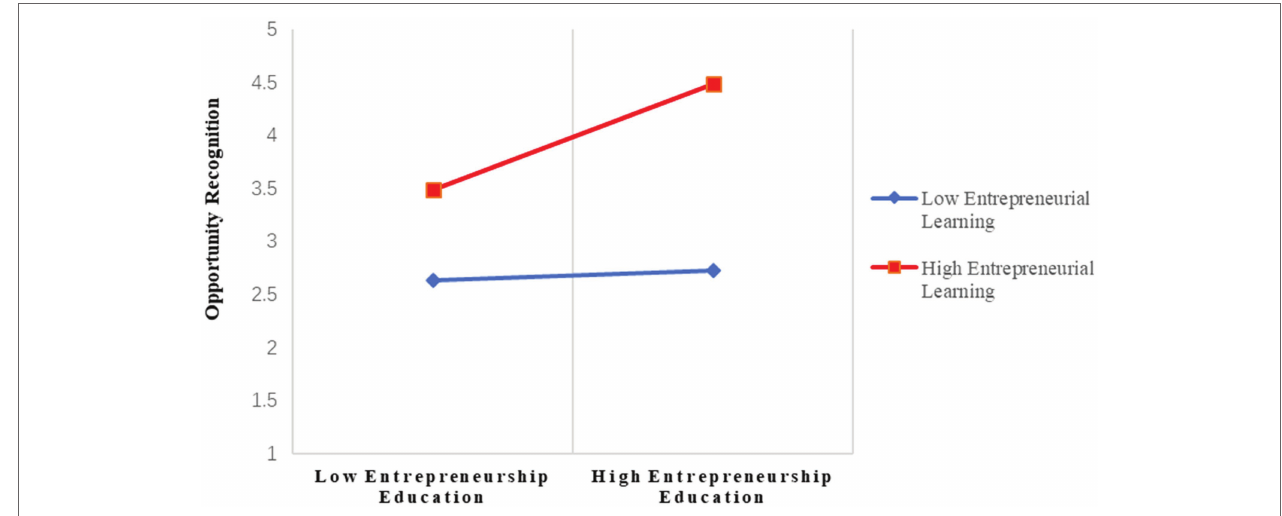
FIGURE 2 | Entrepreneurial learning as a moderator of the cross-level relationship between entrepreneurship education and opportunity recognition. Entrepreneurial learning was centered at groups’ mean values. Entrepreneurship education was centered on the mean of the whole sample of universities.